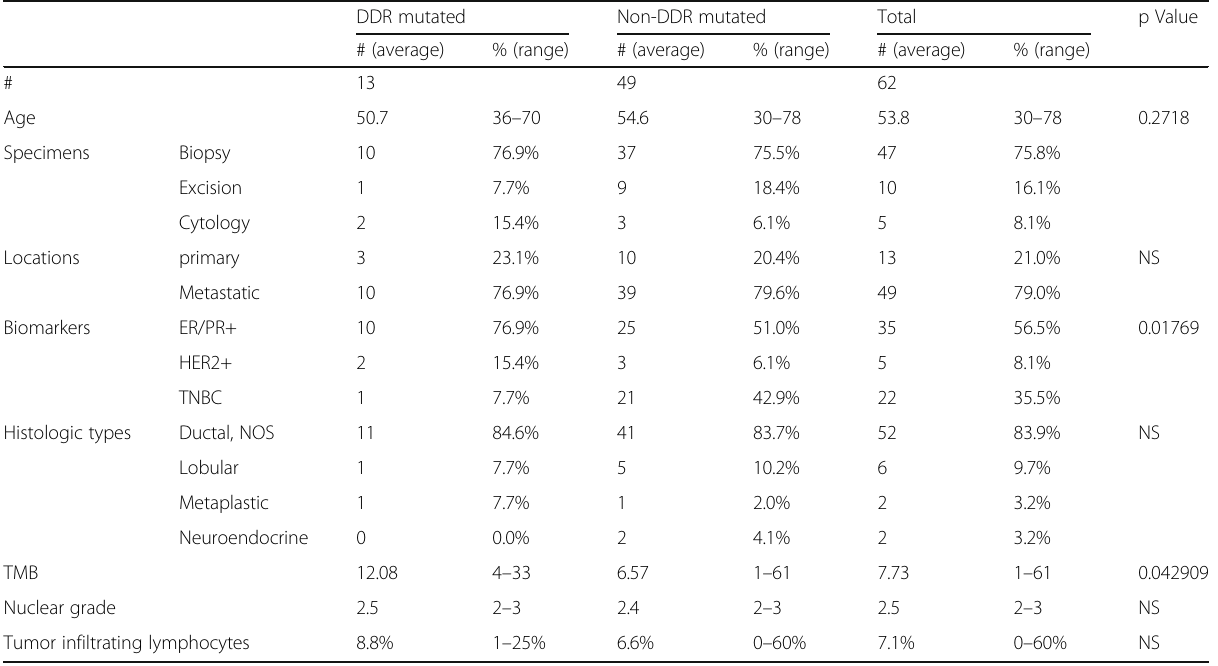
Table 3 Tumor mutation burden between DDR-mutated BCs and non-DDR-mutated BCs DDR mutated